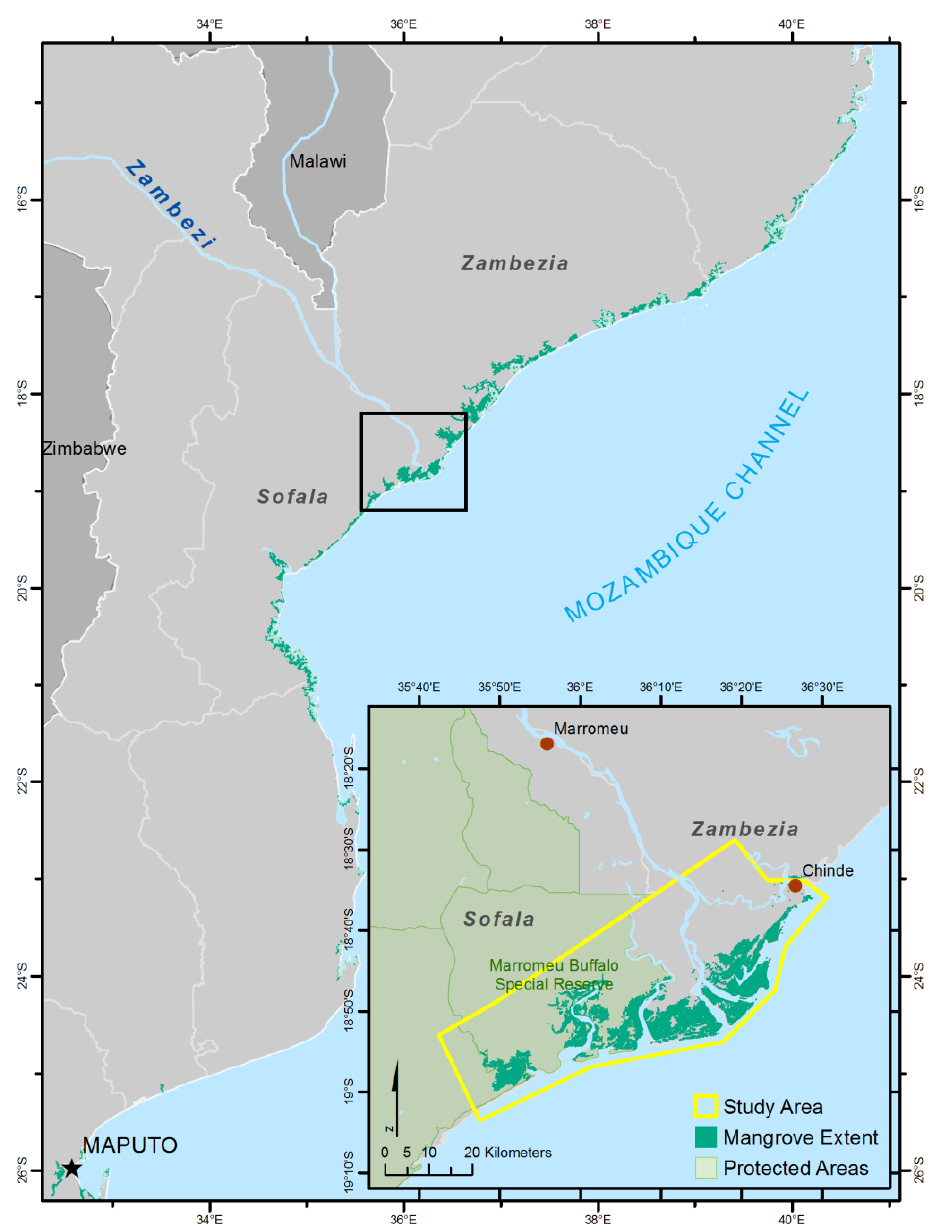
Figure 1. The distribution of mangroves along the southern and central coast of Mozambique [2]. The assessment boundary of mangroves within the Zambezi River Delta was defined from Chinde on the north to the edge of the Marromeu Reserve in the